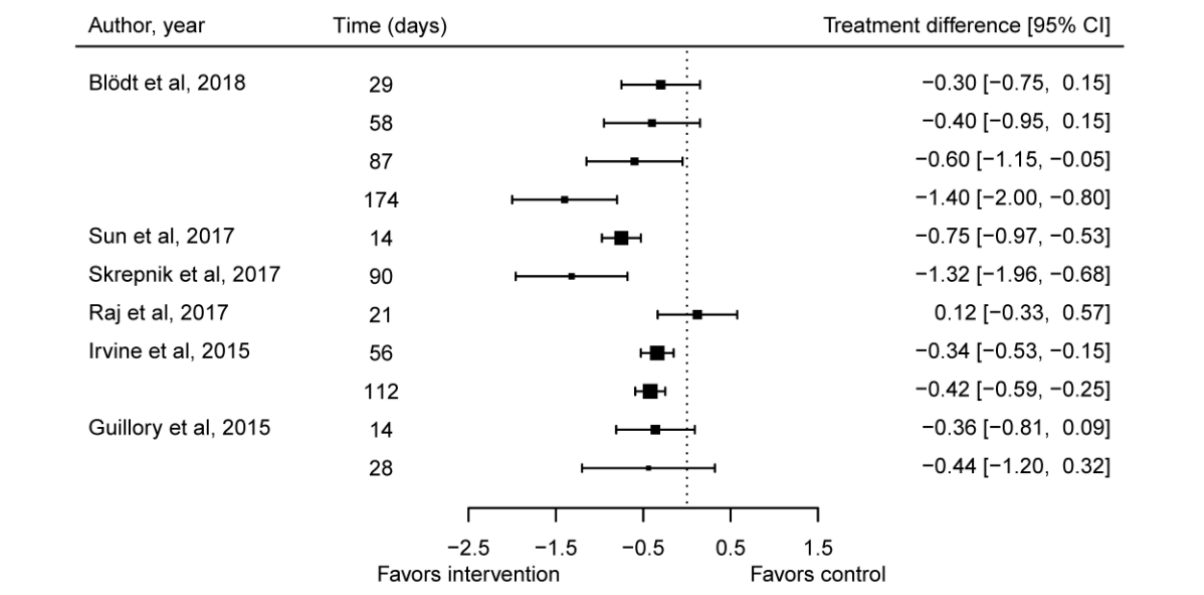
Figure 3. Forest plot of intervention effect on pain in multiple armed studies. Pain scale (Numeric Rating Scale):